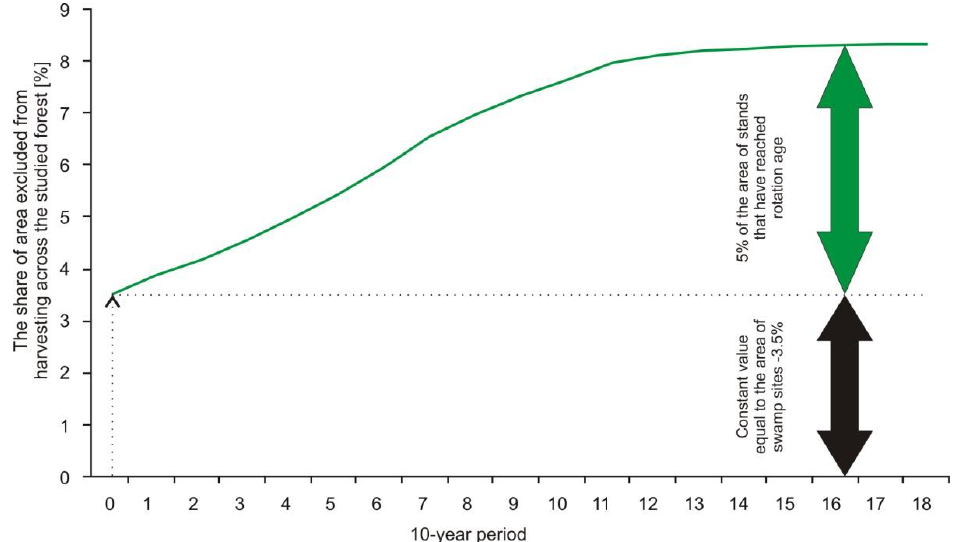
Figure 7. Share of area (green line) excluded from harvesting as a source of retention trees in the long rotation scenario.